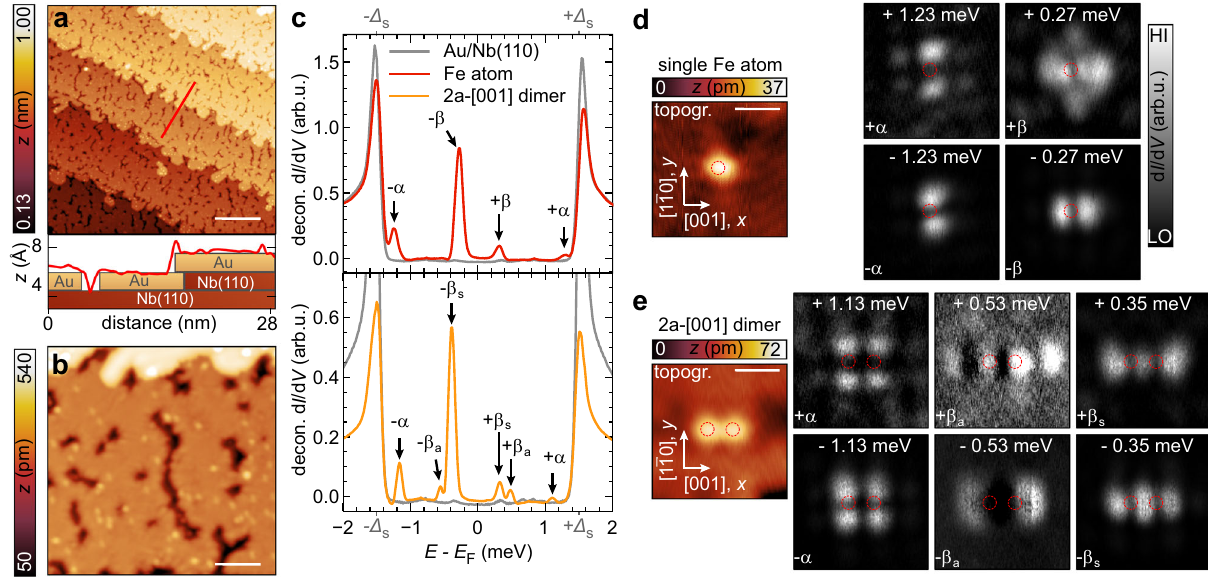
Figure 1 Measured Yu – Shiba – Rusinov (YSR) states of Fe atoms and dimers on monolayer Au on Nb(110). a Scanning tunneling microscope (STM) image of an ultrathin fi lm of Au on Nb(110) with an approximate coverage of 1 monolayer Au and additionally deposited Fe atoms. An extracted line pro fi le along the red line is displayed underneath (red curve). Rectangles show the surface composition underneath the line pro fi le. The white scale bar has a length of 20 nm ( V bias = 50 mV and I = 100 pA). b STM image of randomly distributed Fe atoms on 1 monolayer Au (bottom part of the image) and 2 monolayer Au (topmost part of the image). The white scale bar has a length of 4 nm ( V bias = 6 mV and I = 3 nA). c Deconvoluted d I /d V spectra (decon. d I /d V in arbitrary units, arb. u.) measured on the Au/Nb(110) substrate (gray), a single Fe atom (red), and the center of a dimer of Fe atoms spaced by 2 a along the [001] direction (orange). Black arrows and Greek letters label YSR states. Gray ticks mark the position of the superconducting energy gap of the sample Δ s = 1.50 meV as determined in Supplementary Note 2 ( V stab = 6 mV, I stab = 1 nA and V mod ¼ 20 μ V). d , e STM images (colored images named topogr.) and constant-contour maps (grayscale images) of a single Fe atom ( d ) and a Fe dimer ( e ) spaced by 2 a along the [001] direction. Constant- contour maps were obtained for every energy for which we identi fi ed a peak in the corresponding spectrum of ( c ) as indicated by the corresponding Greek letters. White arrows indicate crystallographic directions, red dashed circles depict the positions of the Fe atoms as determined from the topographies (topogr.), and white scale bars represent a length of 1 nm ( V bias = 6 mV and I = 1